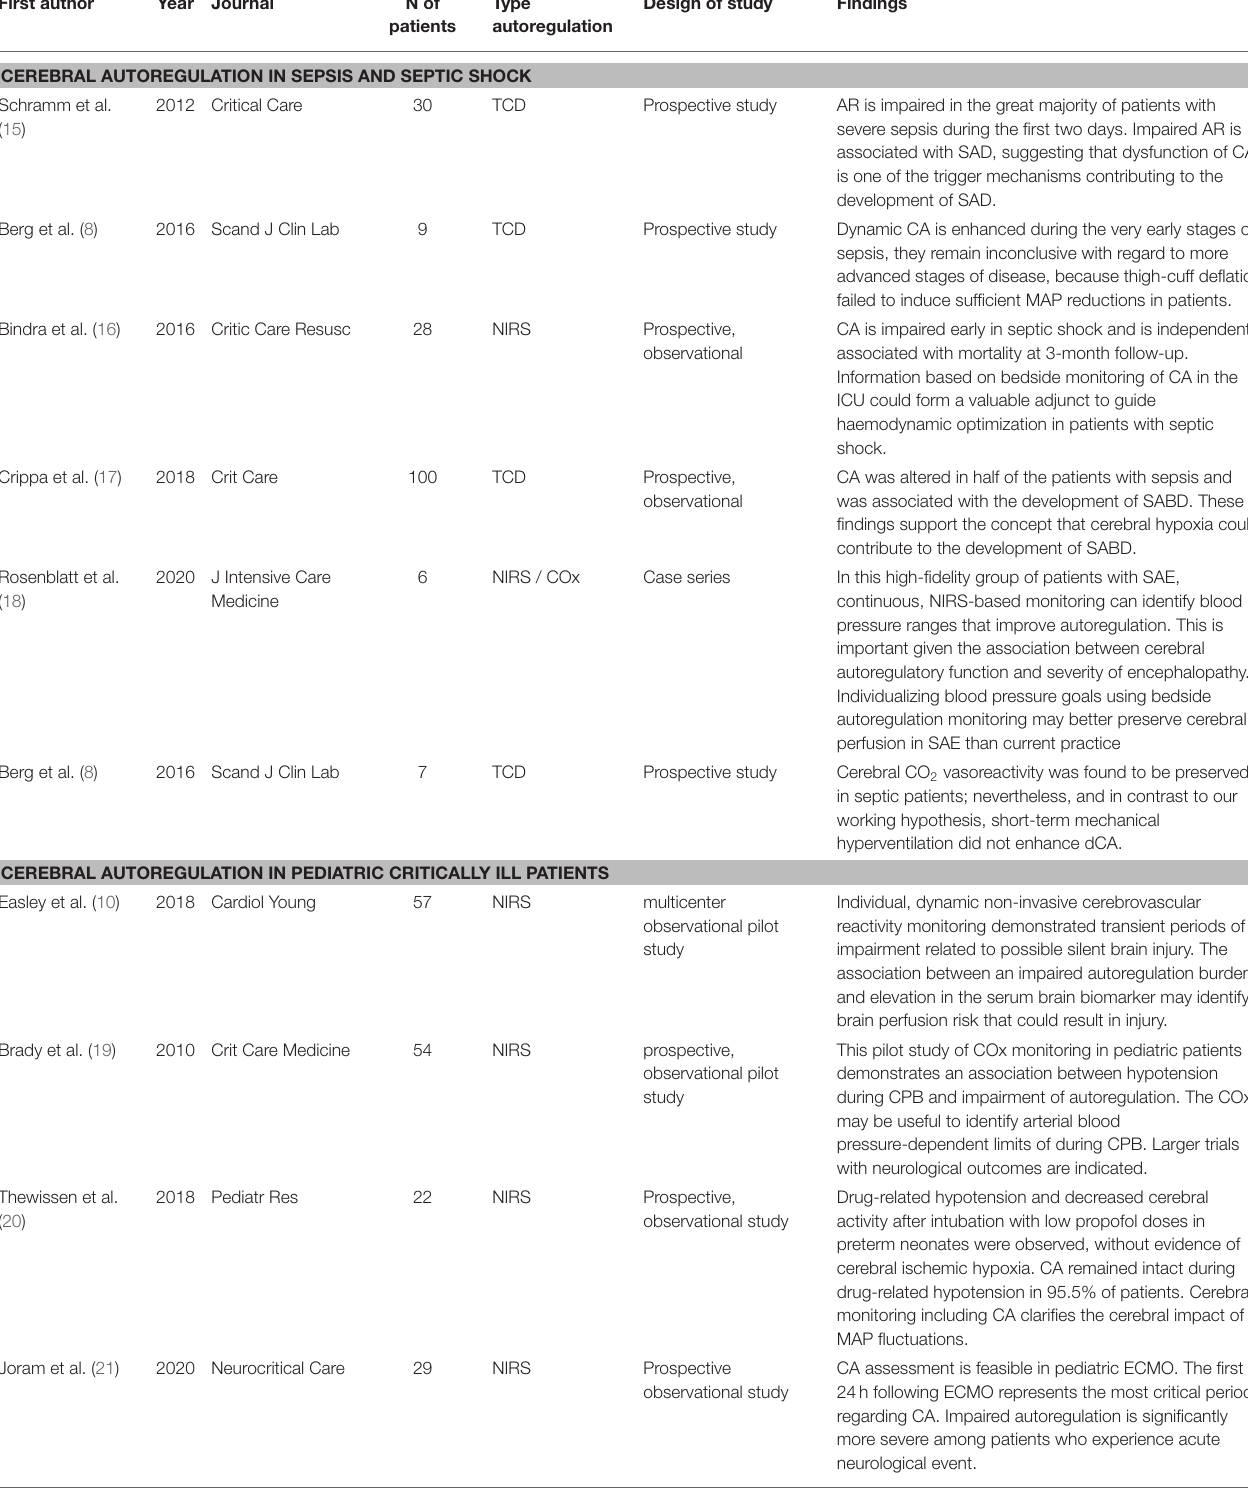
TABLE 1 | Summary of the included studies about CA in sepsis and pediatric population: primary findings, type of method to assess autoregulation, number of patients